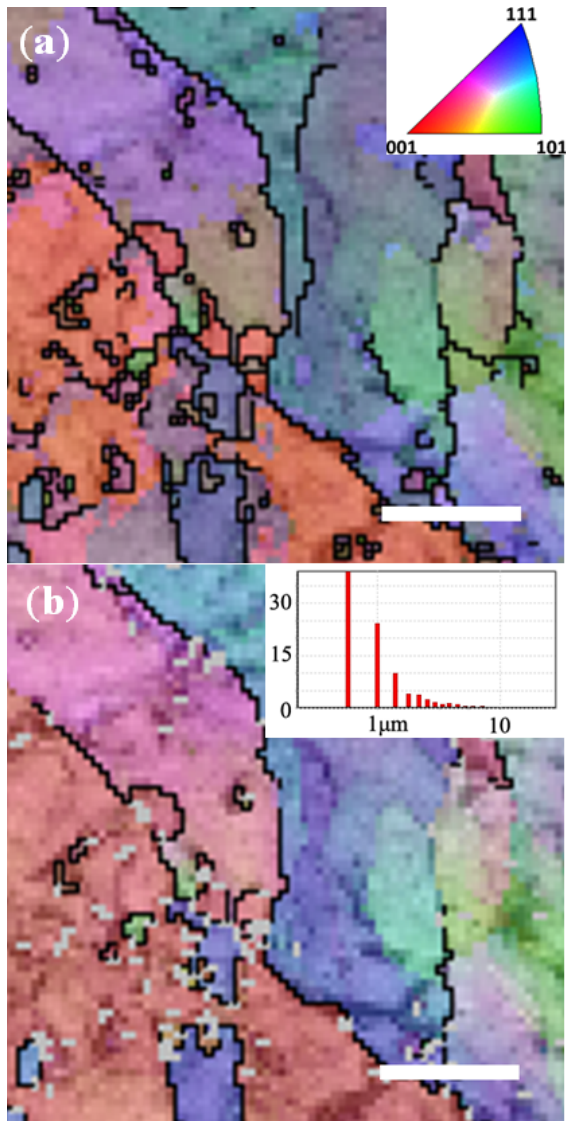
Figure 10. EBSD mapping of CuZn 15 : ( a) before DA; and ( b ) after DA. Scale bars correspond to 5 μm. See Figure S11 for full scale